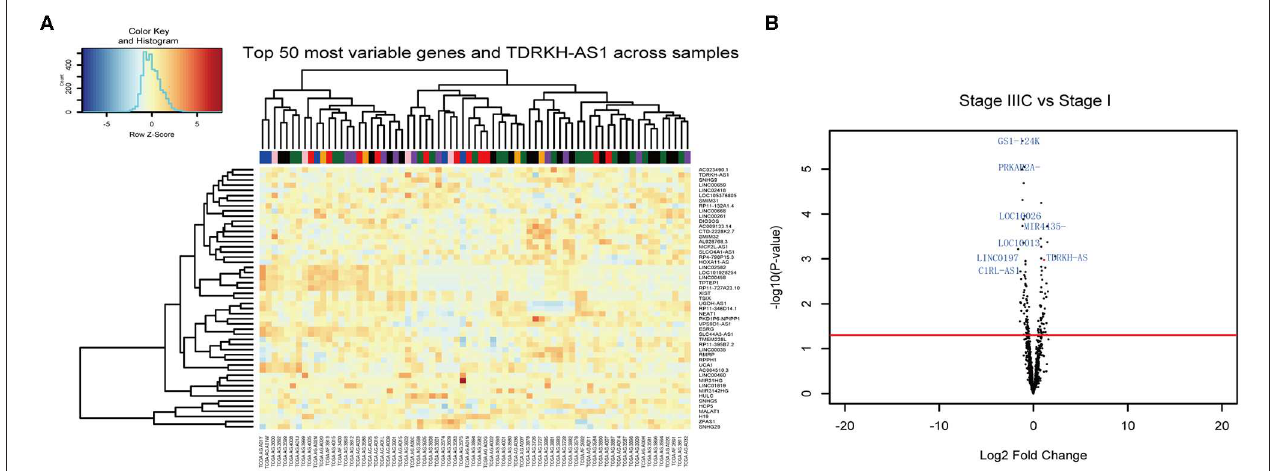
FIGURE 1 | TDRKH-AS1 is a long non-coding antisense RNA that is upregulated in colorectal cancer (CRC). (A) The 71 CRC tissue samples in The Cancer Genome Atlas (TCGA) database were analyzed and sorted into stage I (black), stage II (blue), stage IIA (green), stage III (orange), stage IIB (purple), stage IIIC (pink), and stage IV (red). (B) The long non-coding RNAs (lncRNAs) with high abundance were verified in the CRC TCGA database.